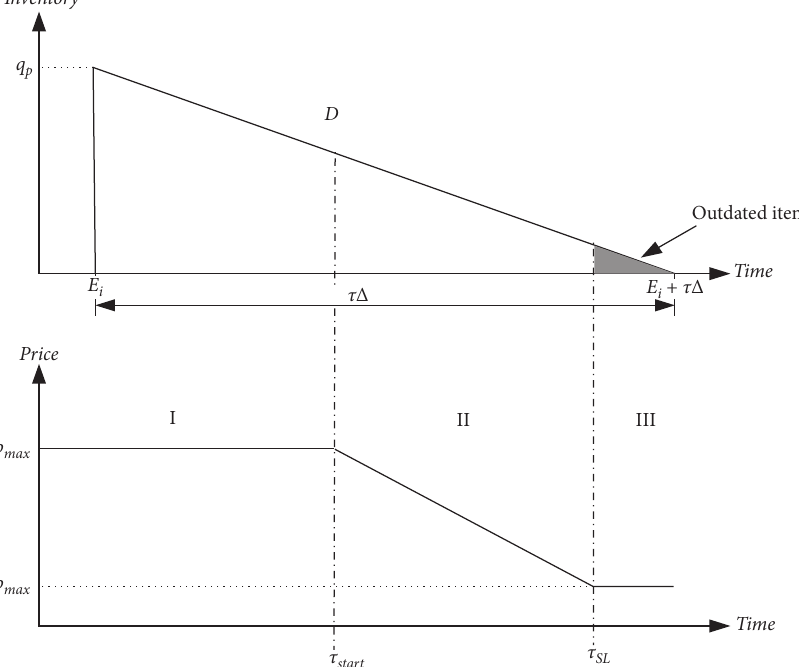
Figure 4: Price function based on the shelf life of each